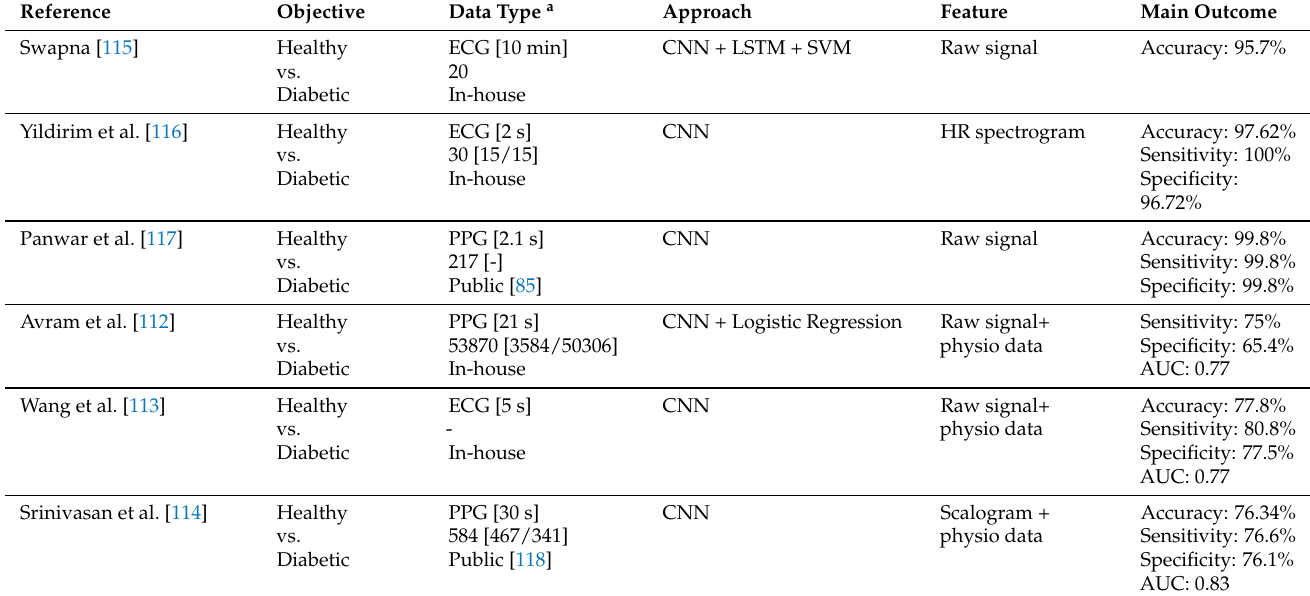
Table 8. Deep learning methods for diabetes